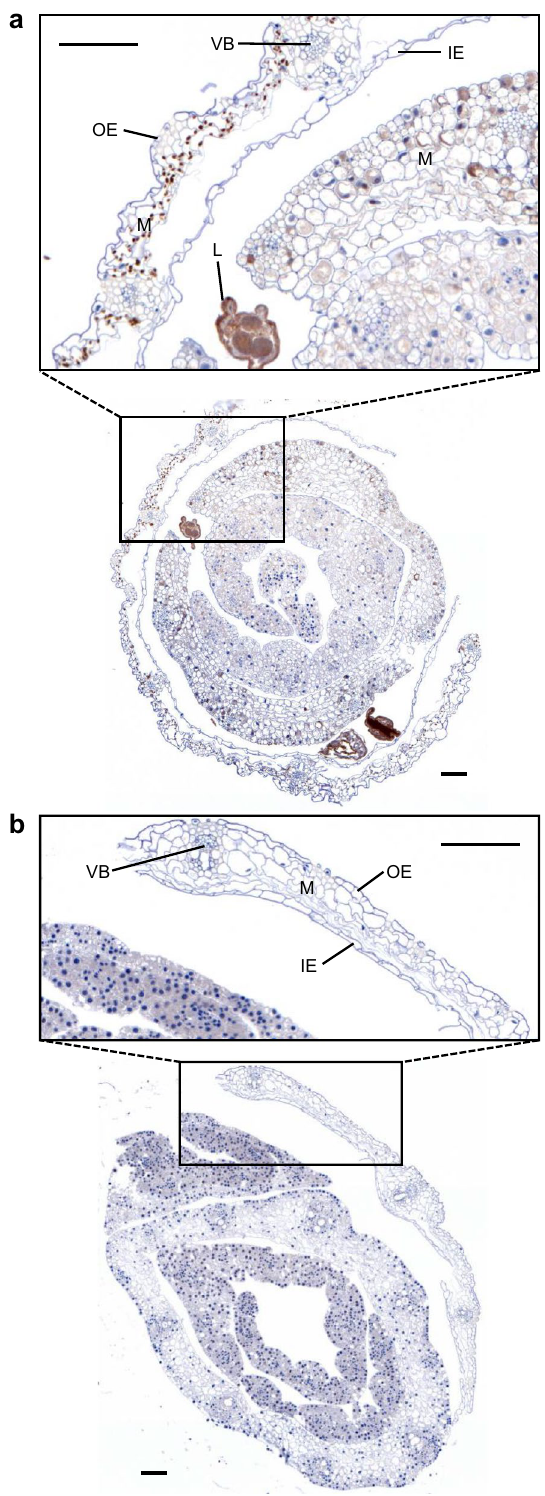
Figure 3. Immunohistochemical localization of MdesGH32 in wheat tissues. ( a ) Biotype L-infested Newton crown tissue collected 7 DAH showing MdesGH32 localized (brown spots) throughout the mesophyll cells (M) between the outer epidermis (OE) and inner epidermis (IE) of the leaf sheath (inset) being fed on by larvae (L). ( b ) Uninfested Newton tissue showing intact mesophyll cells with no MdesGH32 staining (inset). VB vascular bundle; scale bar, 100